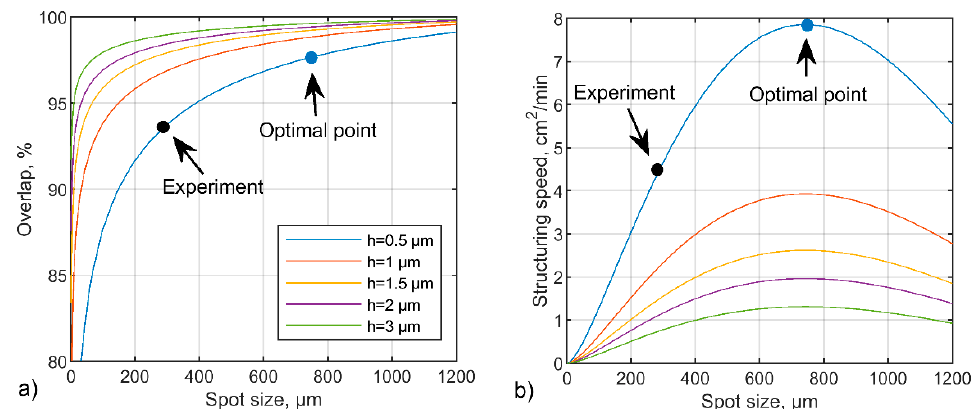
Figure 6. ( a ) Calculated isocurves representing the set of processing parameters, namely spot overlap